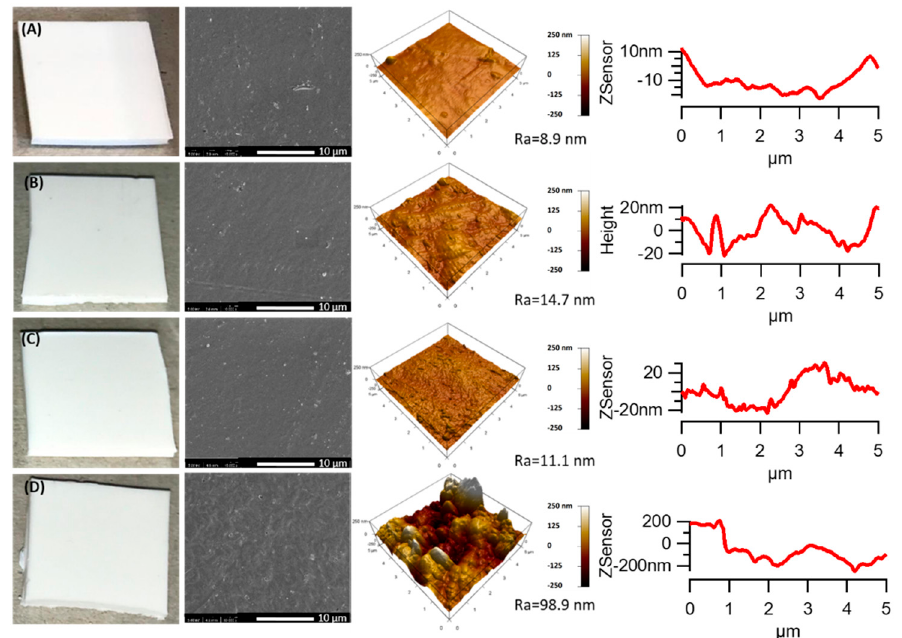
Figure 2. SEM and AFM images of the PHBV/TiO 2 samples before ( A ) and after accelerated weathering: ( B ) 500 h; ( C ) 1000 h; and ( D ) 2000 h. Note: R a represents the roughness parameter.